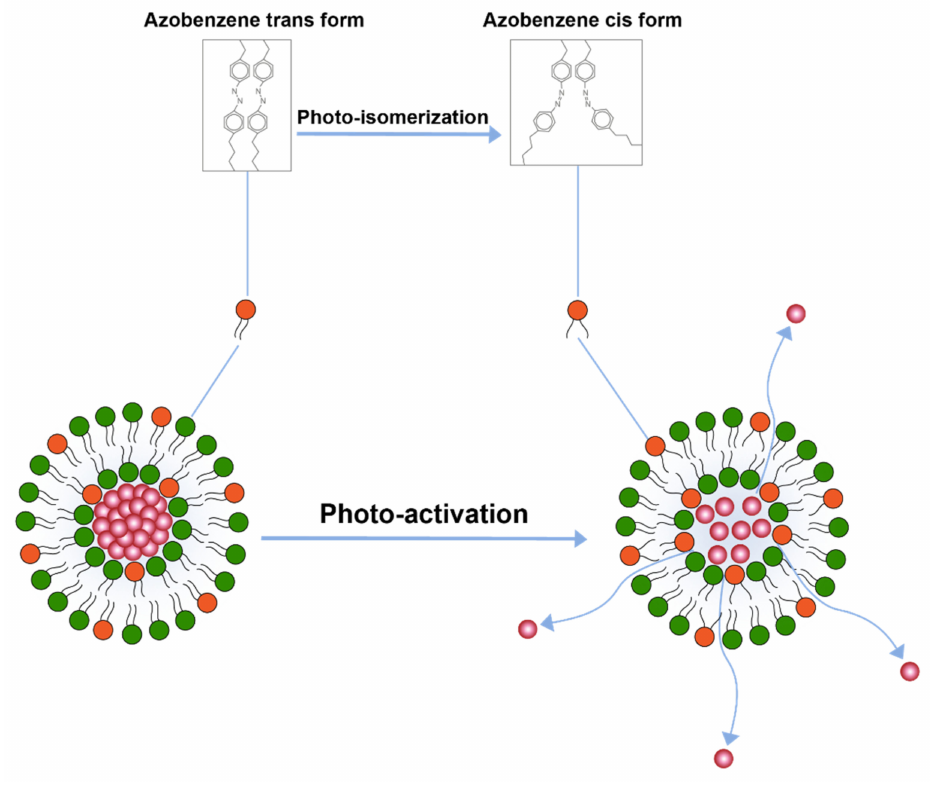
Figure 5. Drug release from liposomes by photo-isomerization of